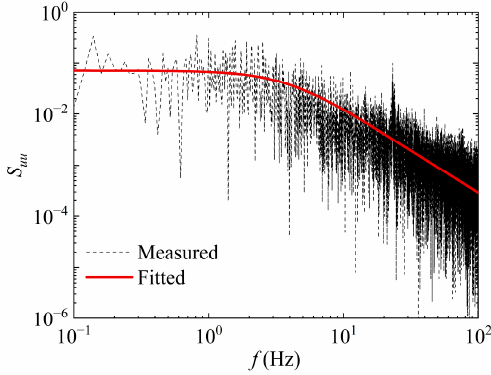
Figure 3. Typical longitudinal turbulence spectra ( S uu ) .